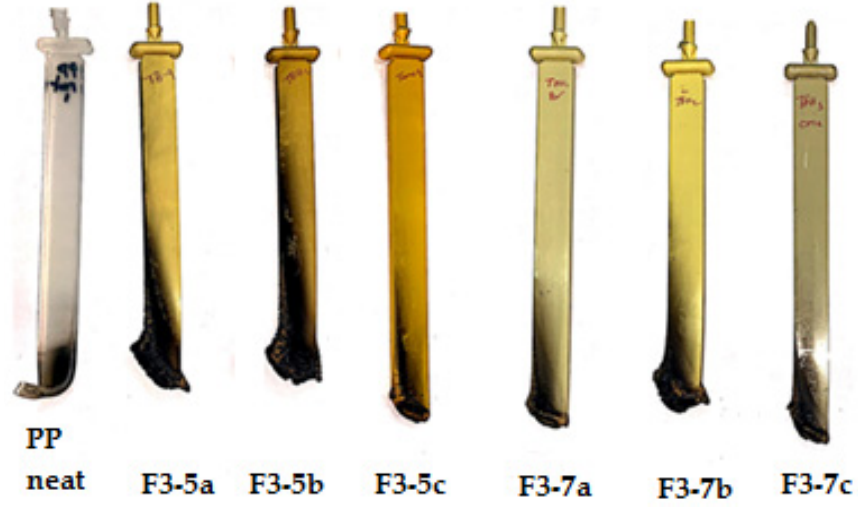
Figure 10. Flammability test of PP composites. Table 5. Flammability test data of the neat PP and its composites. Table 6. Comparison of the flammability characteristics of the prepared polymers with other